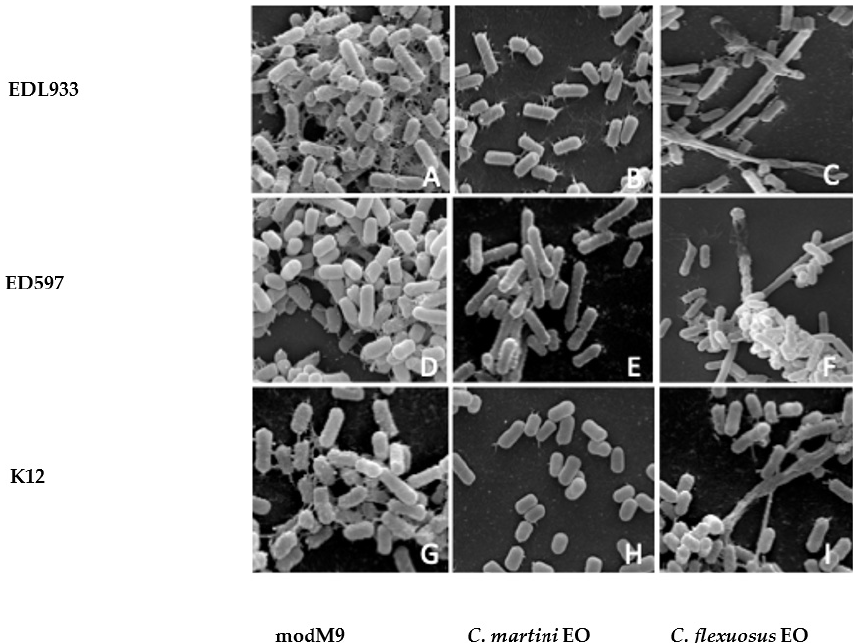
Figure 4. Effect of C. martini ( B , E , H ) and C. flexuosus ( C,F , I ) EOs on biofilm formation by E. coli strains (EDL933 strain A-C, ED597 strain D-F, K12strain G-I). Scanning electron microscope (SEM) was used to examine biofilm cells grown on glass coverslips in modM9 in the presence ( B , C , E , F , H , I ) or absence ( A , D , G ) of EOs for 24 h (magnification 5000 ×